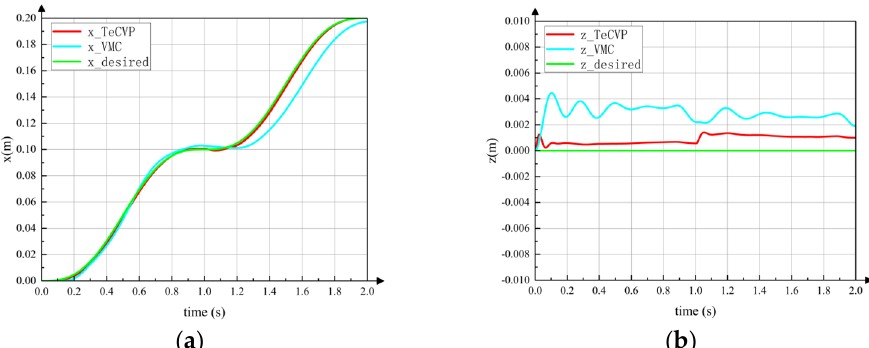
Figure 10. Displacement of torso in tripod gait. The same desired trajectory as the green line in the figures is tracked using the TeCVP and VMC. The blue line is the actual trajectory using VMC, while the red line is the actual trajectory using VMC. ( a ) Displacement x. ( b ) Displacement z.